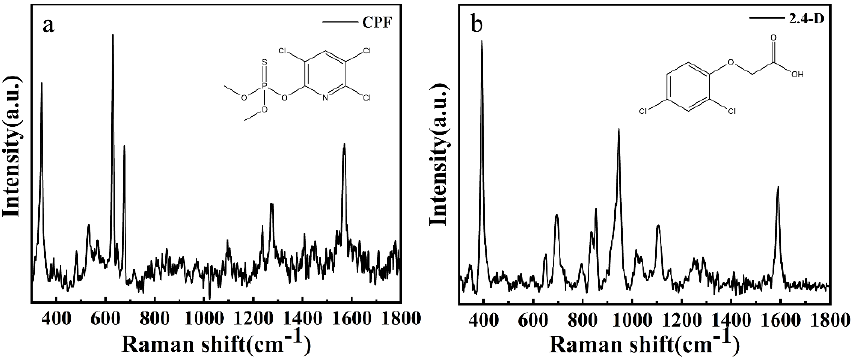
Figure 3. The molecular structure and Raman spectrum of ( a ) CPF and ( b ) 2.4 − D.